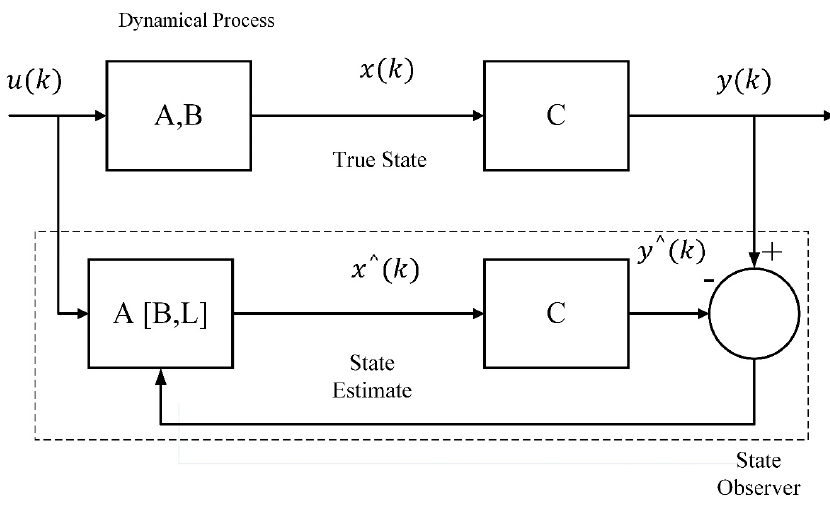
Figure 3. Block Diagram of Observer Implementation.